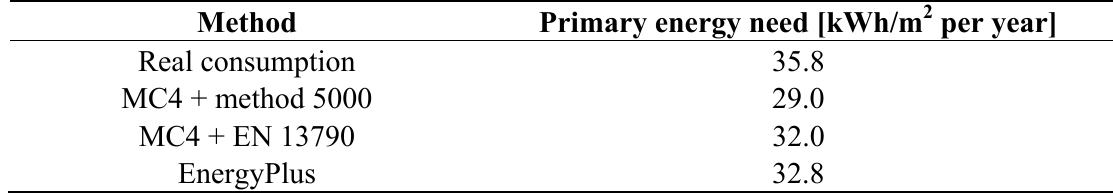
Table8. Primary energy need for the analyzed flat: real values and results of the three simulation